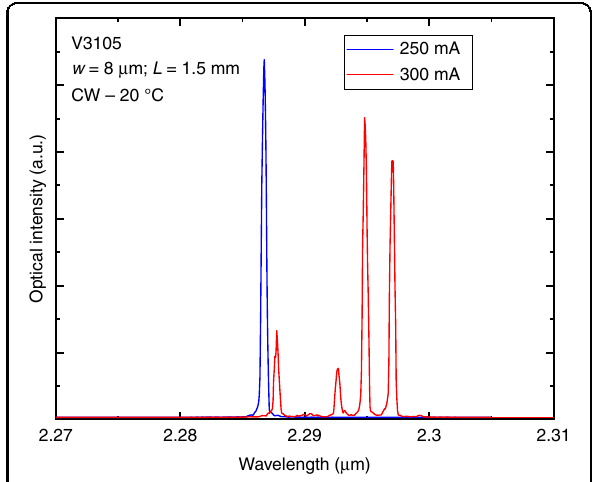
Fig. 7 Emission spectra taken in CW at room temperature from a 8 µm × 1.5 mm GaSb DLs grown on a Si substrate with a 0.18° residual miscut angle. The wavelength shift is due to the different drive currents (250 and 300 mA) that induce different internal temperature of the DL